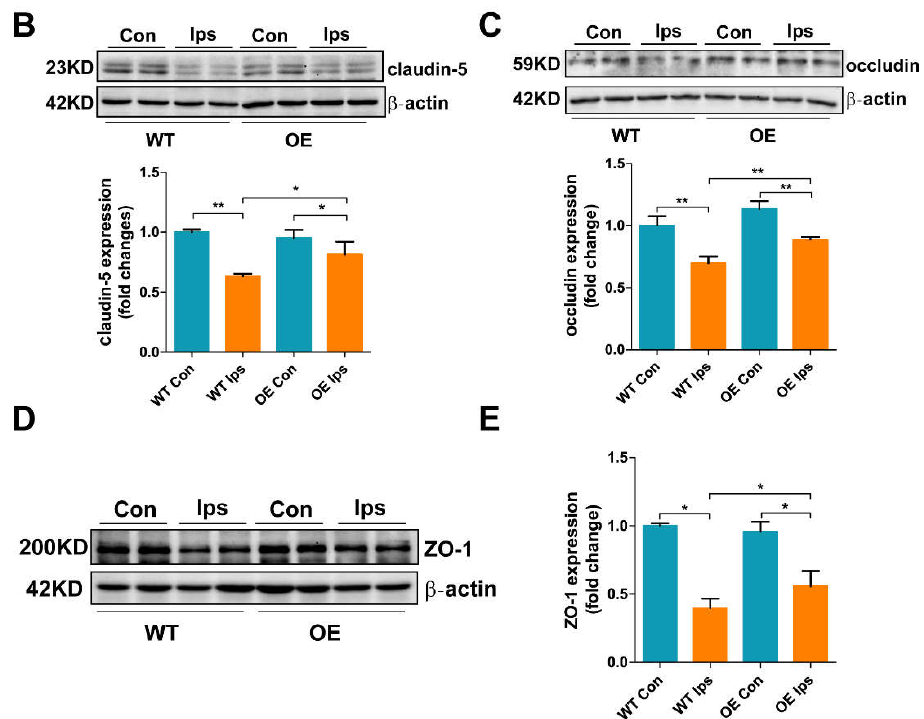
Figure 2. Overexpression of FtMt increases tight junctional integrity in cerebral I/R. ( A ) Immunoflu- orescence staining for claudin-5, occludin, ZO-1 and CD31 with DAPI counterstaining in the cortex of WT and OE mice after I/R ( n = 3). Scale bar: 100 µm. Western blot analysis of ( B ) claudin-5, ( C ) occludin and ( D , E ) ZO-1 from ischemic brains. The data are expressed relative to the mean value in the WT Con group ( n = 4). The results are presented as the mean SEM. * p < 0.05, ** p < 0.01.